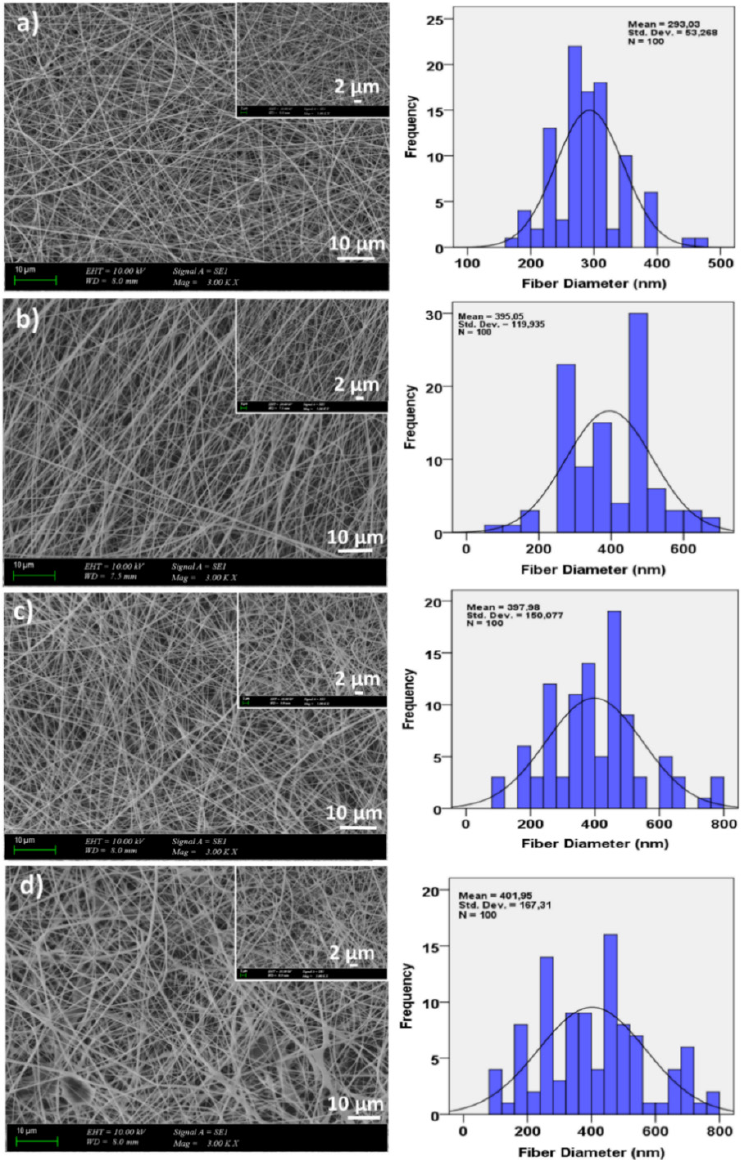
Figure 1. SEM images of the non-crosslinked 13% PVA ( a ), 13% PVA/0.5% GEL ( b ), 13% PVA/1% GEL ( c ), 13% PVA/3% GEL ( d GEL ( c ), 13% PVA/3% GEL ( d ).